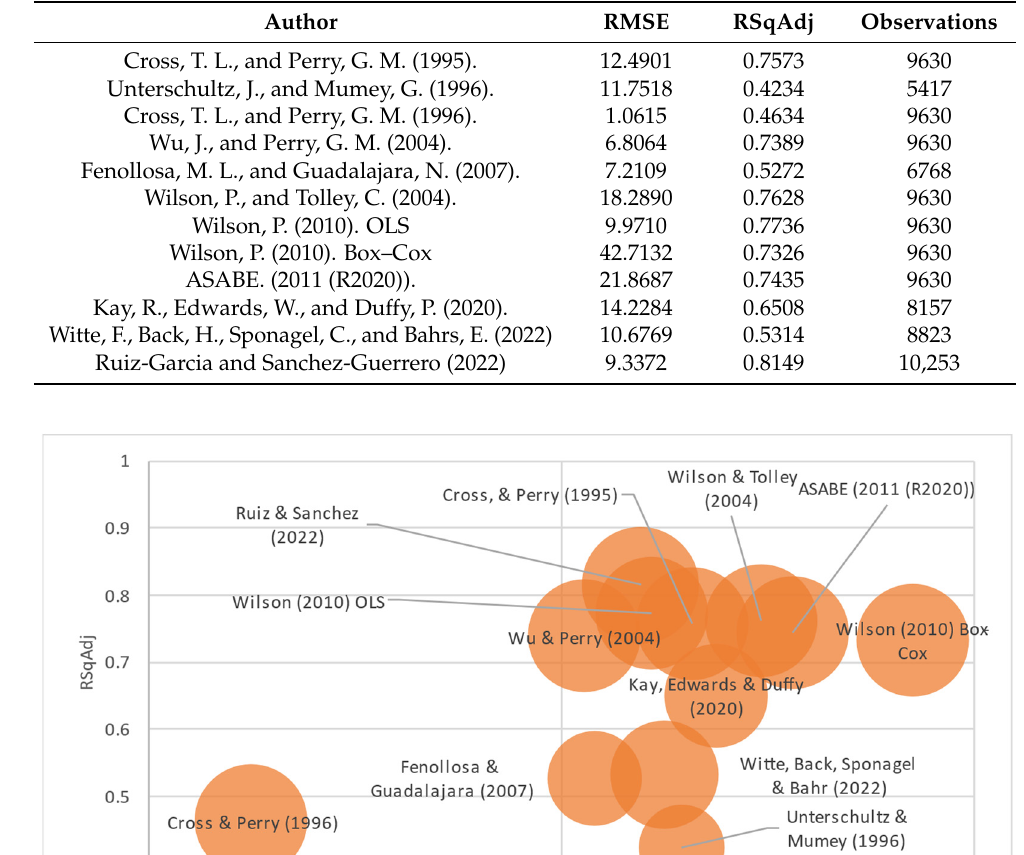
Table 12. Results of previous studies.